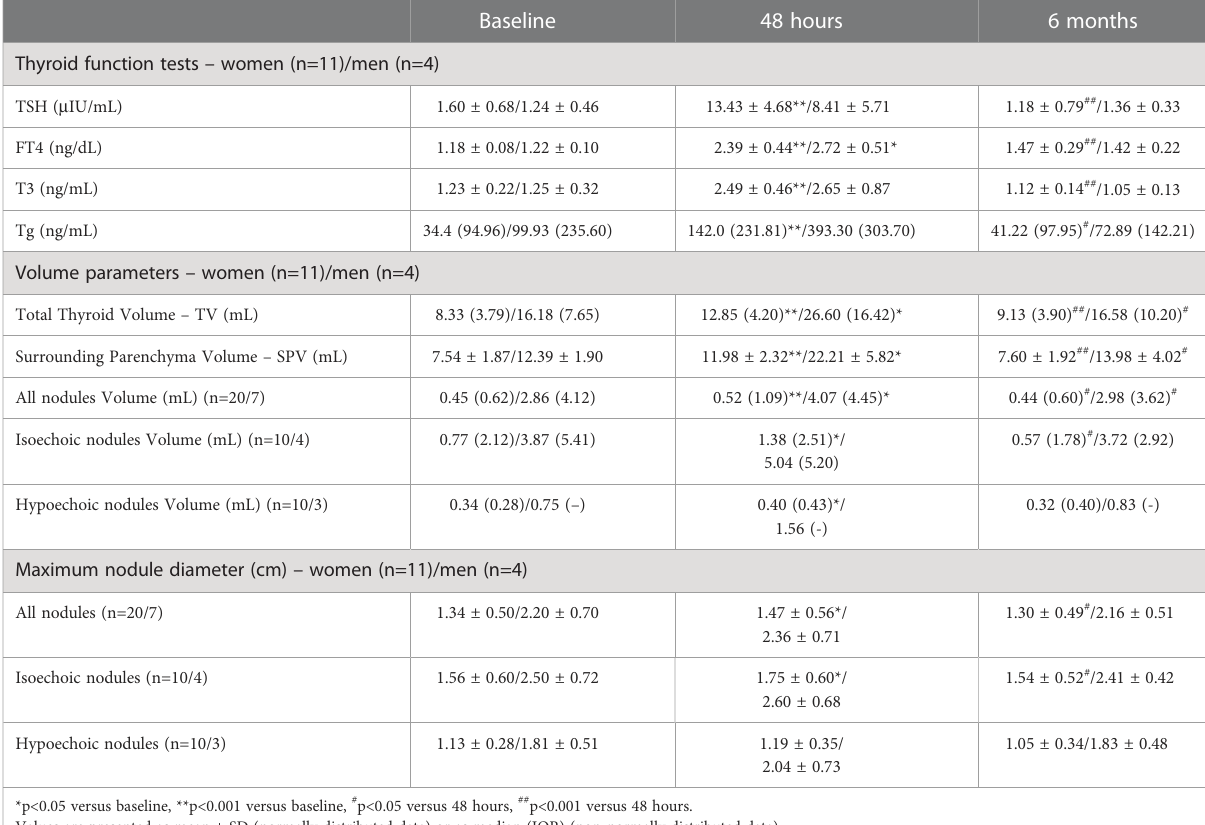
TABLE 2 Thyroid function tests, total thyroid, surrounding parenchyma and nodules ’ volumes, and maximum nodule diameter measured before and 48 hours and 6 months after the administration of human recombinant TSH, in male and female